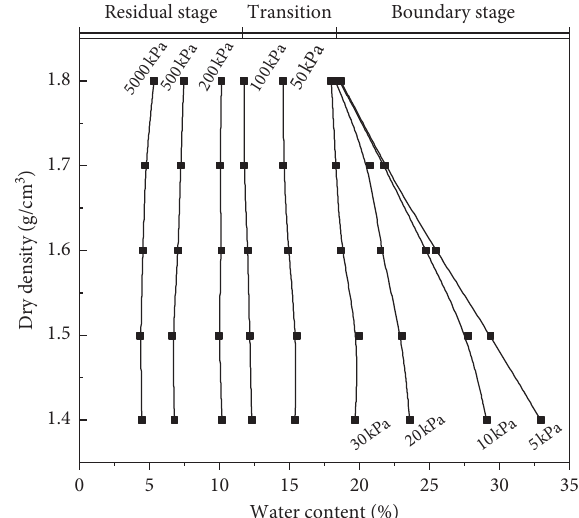
Figure 8: Equi-suction lines of specimens with different initial dry